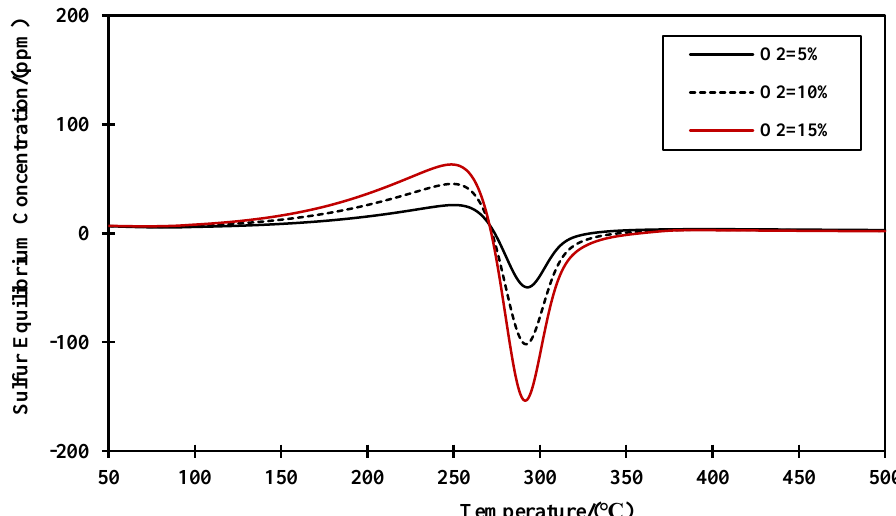
Figure 12. The relationship between the equilibrium concentration of sulfur and the temperature at different O 2 concentrations (SO 2 :500 ppm, H 2 O: 3%).